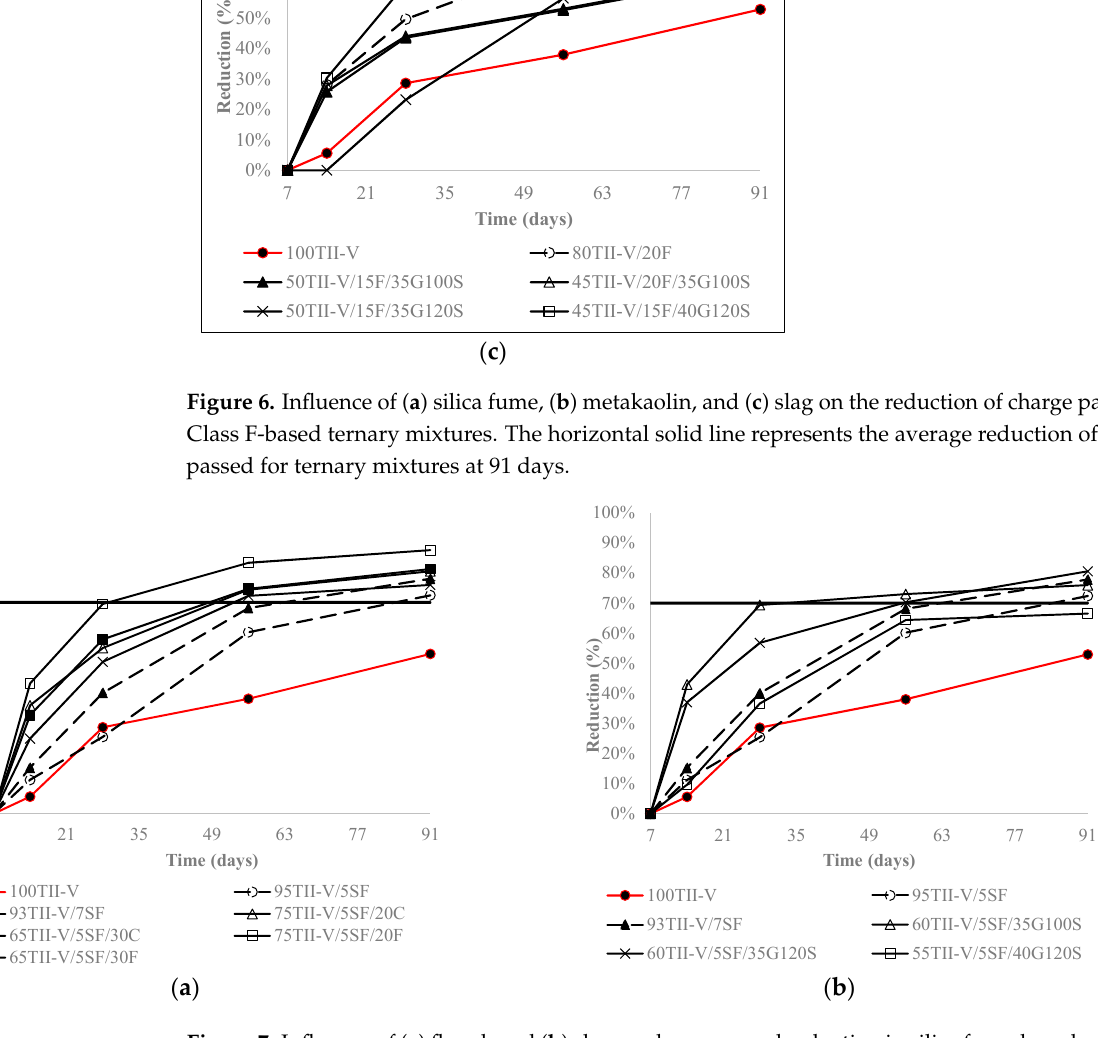
Figure 7. Influence of ( a ) fly ash and ( b ) slag on charge passed reduction in silica fume-based mixtures. The horizontal solid line represents the average reduction of charge passed for ternary mixtures at 91 days.